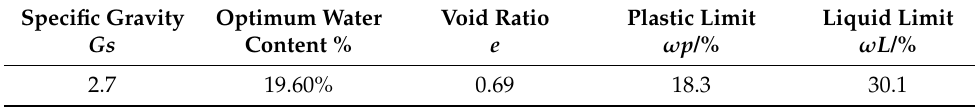
Table 1. Basic physical properties of silt.